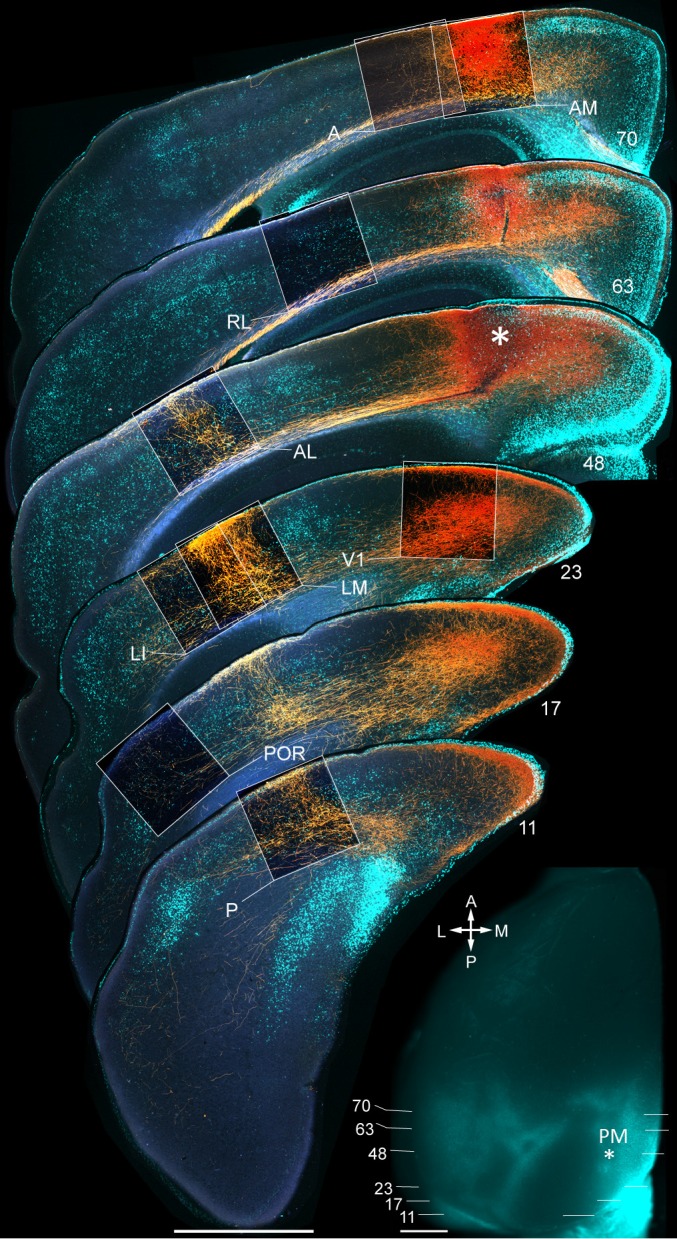
Axonal projections (yellow/orange) from PM to V1, LM, LI, P, POR, AL, RL, AM and A, upon BDA injection into PM.Calossally projecting neurons (light blue, labeled with bisbenzimide) provide landmarks for areal identification (Wang and Burkhalter, 2007). Boxed regions show projections to target areas. Asterisk in section 48 denotes a region in PM adjacent to the injection site. Inset: Left hemisphere in situ shows injection site in PM (asterisk) and positions of coronal slices shown above. Scale bars, 1 mm.